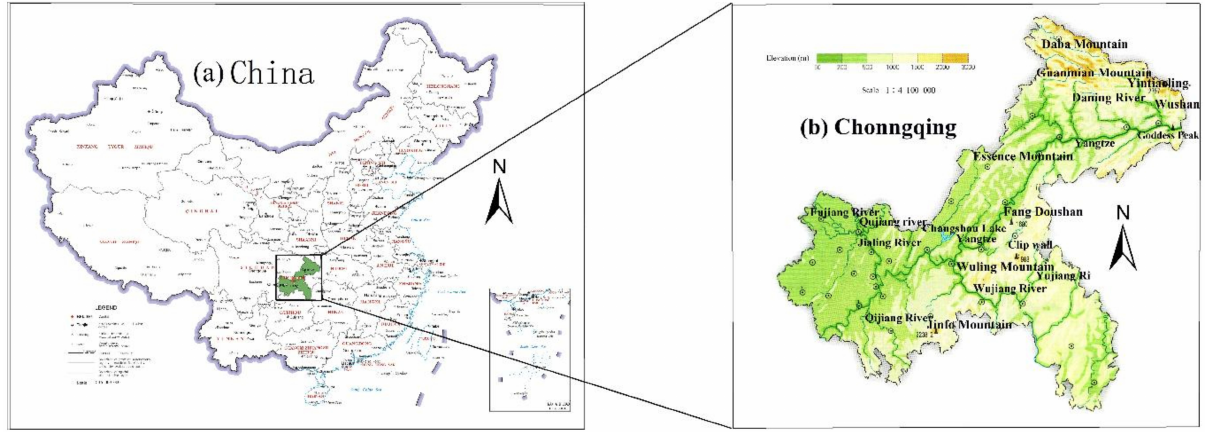
Figure 1. Location of the study area: ( a ) China, ( b ) Chongqing.